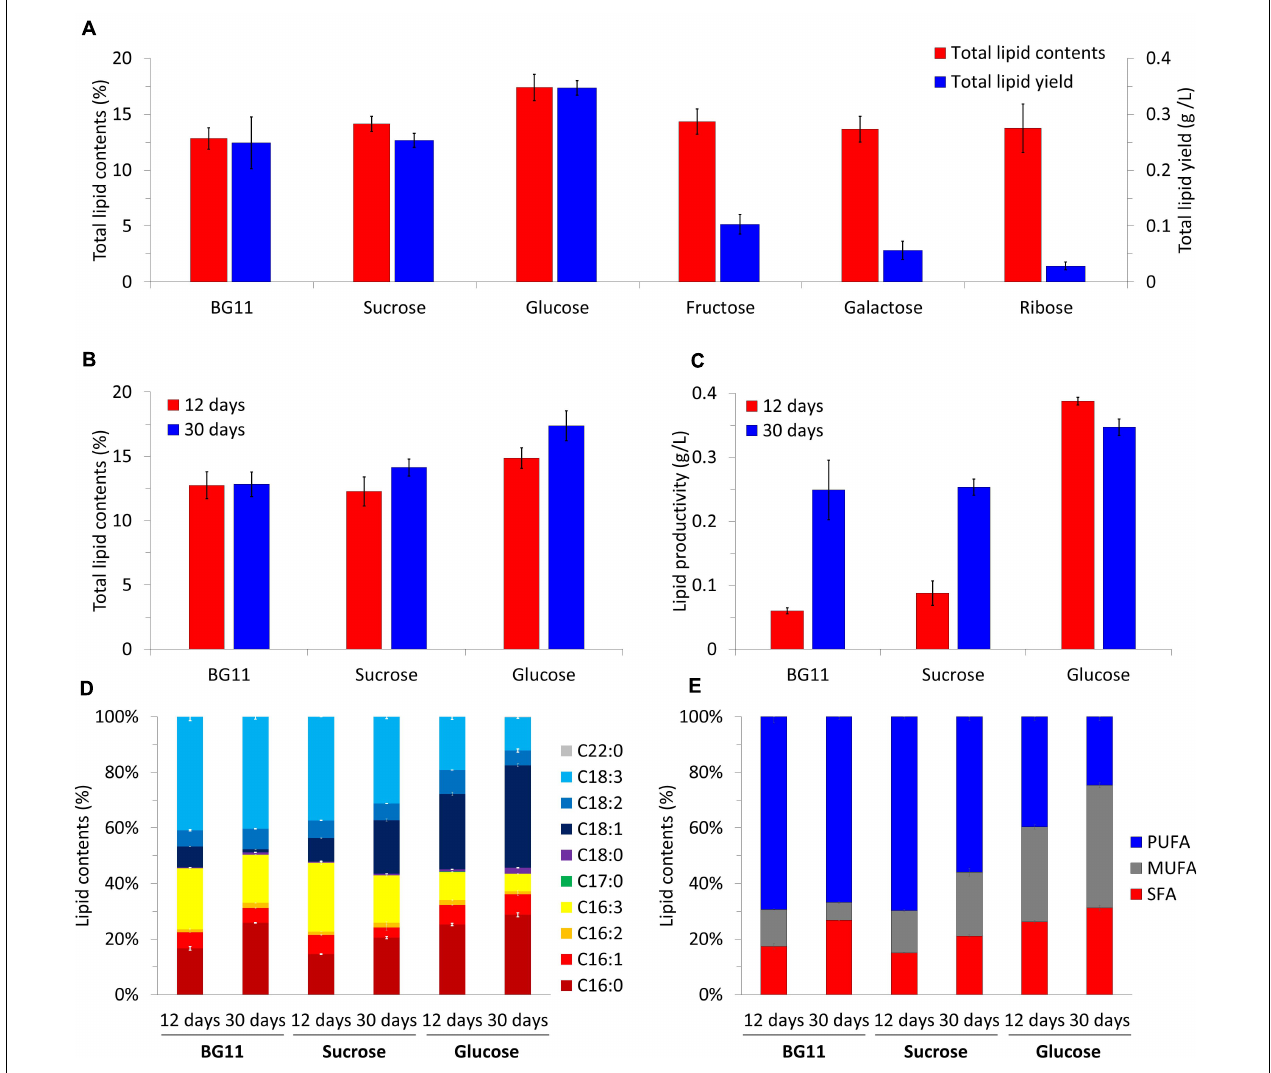
FIGURE 5 | Total lipid contents and total lipid yields of B. sudetica KNUA107 under photoautotrophic (BG11) and mixotrophic (sucrose, glucose, fructose, galactose, and ribose) conditions (A) . Comparison of harvested biomass at days 12 and 30 under three conditions with high lipid productivity, including total lipid contents (B) , lipid productivity (C) , fatty acid composition (D) , and fatty acid saturation ratio (E) . The results are expressed as the ratio of lipid and fatty acid contents, which are defined as 100%. Marked characteristics are annotated in Supplementary Table 2